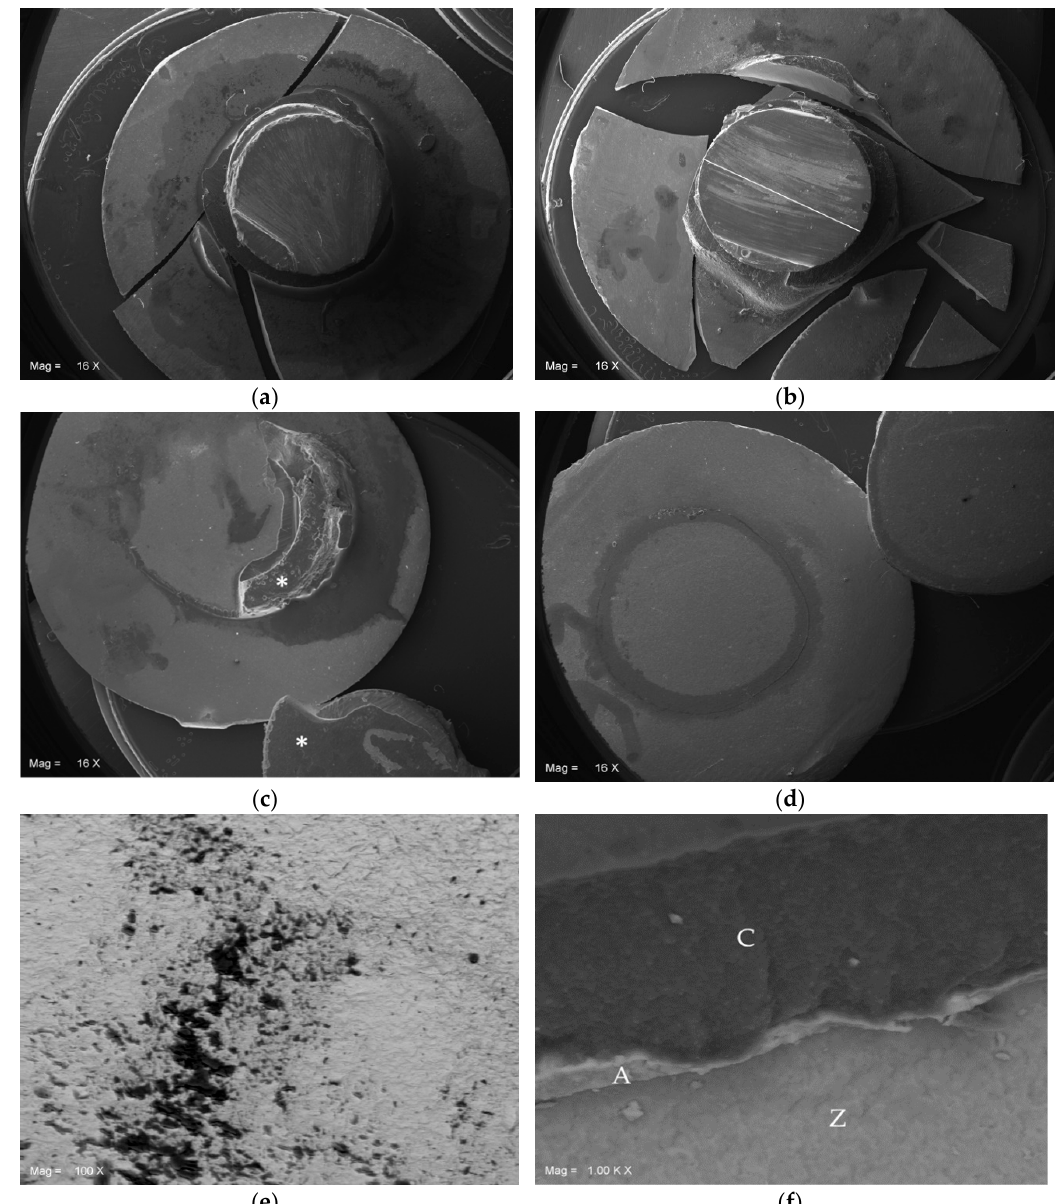
Figure 6. SEM images of representative specimens among groups. ( a ) P 10MDP: cohesive failure within the Y-TZP mass. The resin cylinder remained attached to the center of Y-TZP disk. Mag 16×; ( b ) S 10MDP: cohesive failure within the Y-TZP mass. The resin cylinder remained attached to a fragment of Y-TZP disk. Mag 16×; ( c ) P no 10MDP: adhesive failure. A part of the resin cement mass (*) remained undetached from Y-TZP and resin composite, respectively. Mag 16×; ( d ) S no 10MDP: adhesive failure. The resin cement completely detached from the substrates: the resin cylinder in the upper right corner, and the Y-TZP disk at the center. Mag 16×; ( e ) Particular of Figure 6c: the residual resin cement and 10-MDP containing adhesive (black spots) flood the notches of sandblasted Y-TZP sandblasted surface (grey). Mag 100×; ( f ) Particular of Figure 6c: adhesive interface 10-MDP primer containing (A) comprised between resin cement (C) and Y-TZP (Z). Mag 1000×.